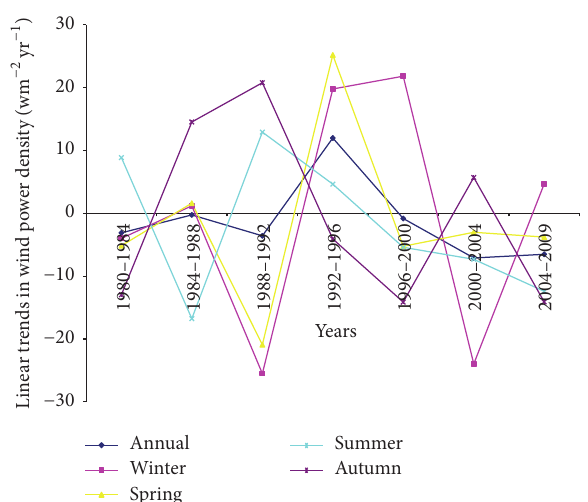
Figure 14: 5-year (1980–1984, 1984–1988, 1988–1992, 1992–1996, 1996–2000, 2000–2004, and 2004–2009) variation of wind power density for the year and seasons in the ECS, unit: w/m 2 yr −1